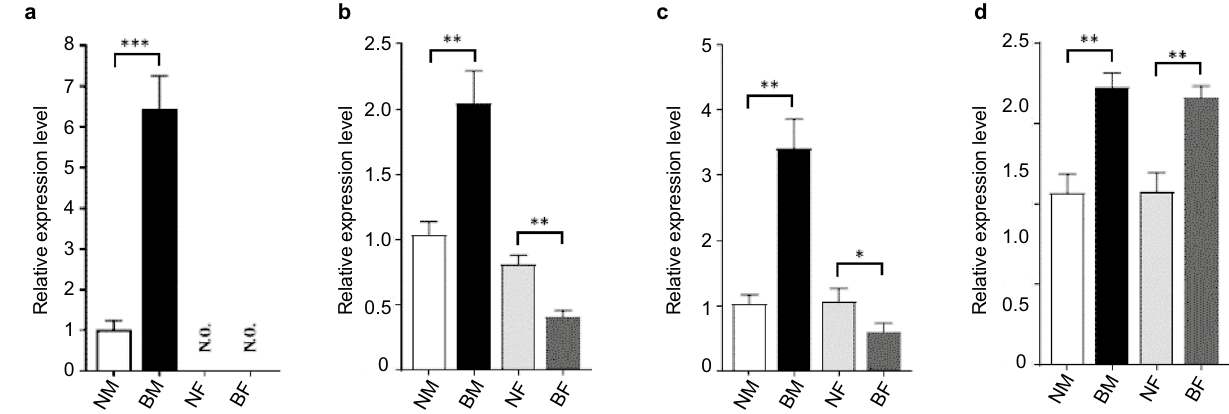
Figure 8. Expressions of MYOZ1 ( a ), PDLIM5 ( b ), LMO7 ( c ), and TFRC ( d ), in muscle and adipose samples. (* p value < 0.05, ** p value < 0.01, *** p value <